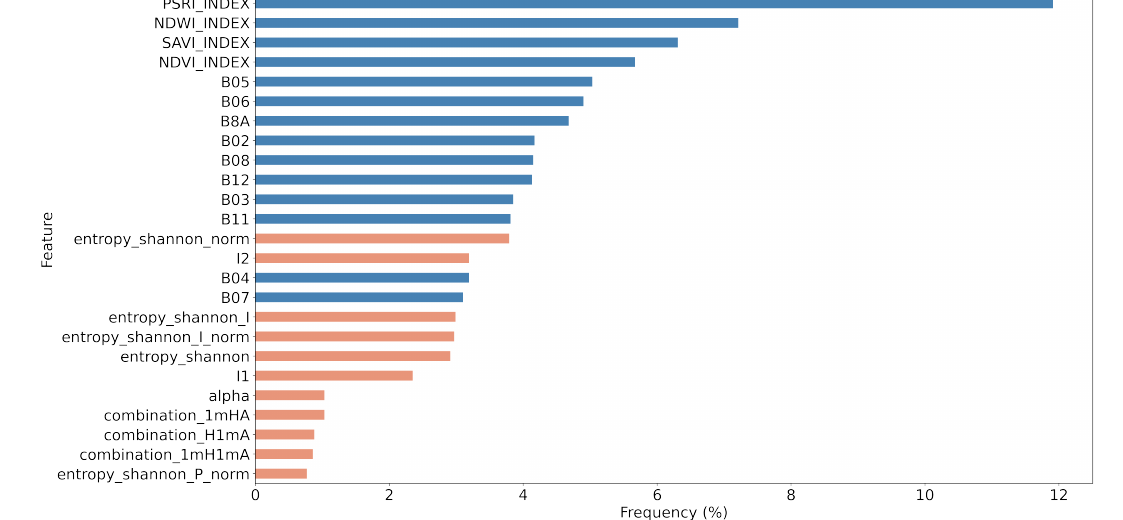
Figure 11. Feature importance of each feature without clouds. Blue indicates Sentinel-2 and orange Sentinel-1 features.